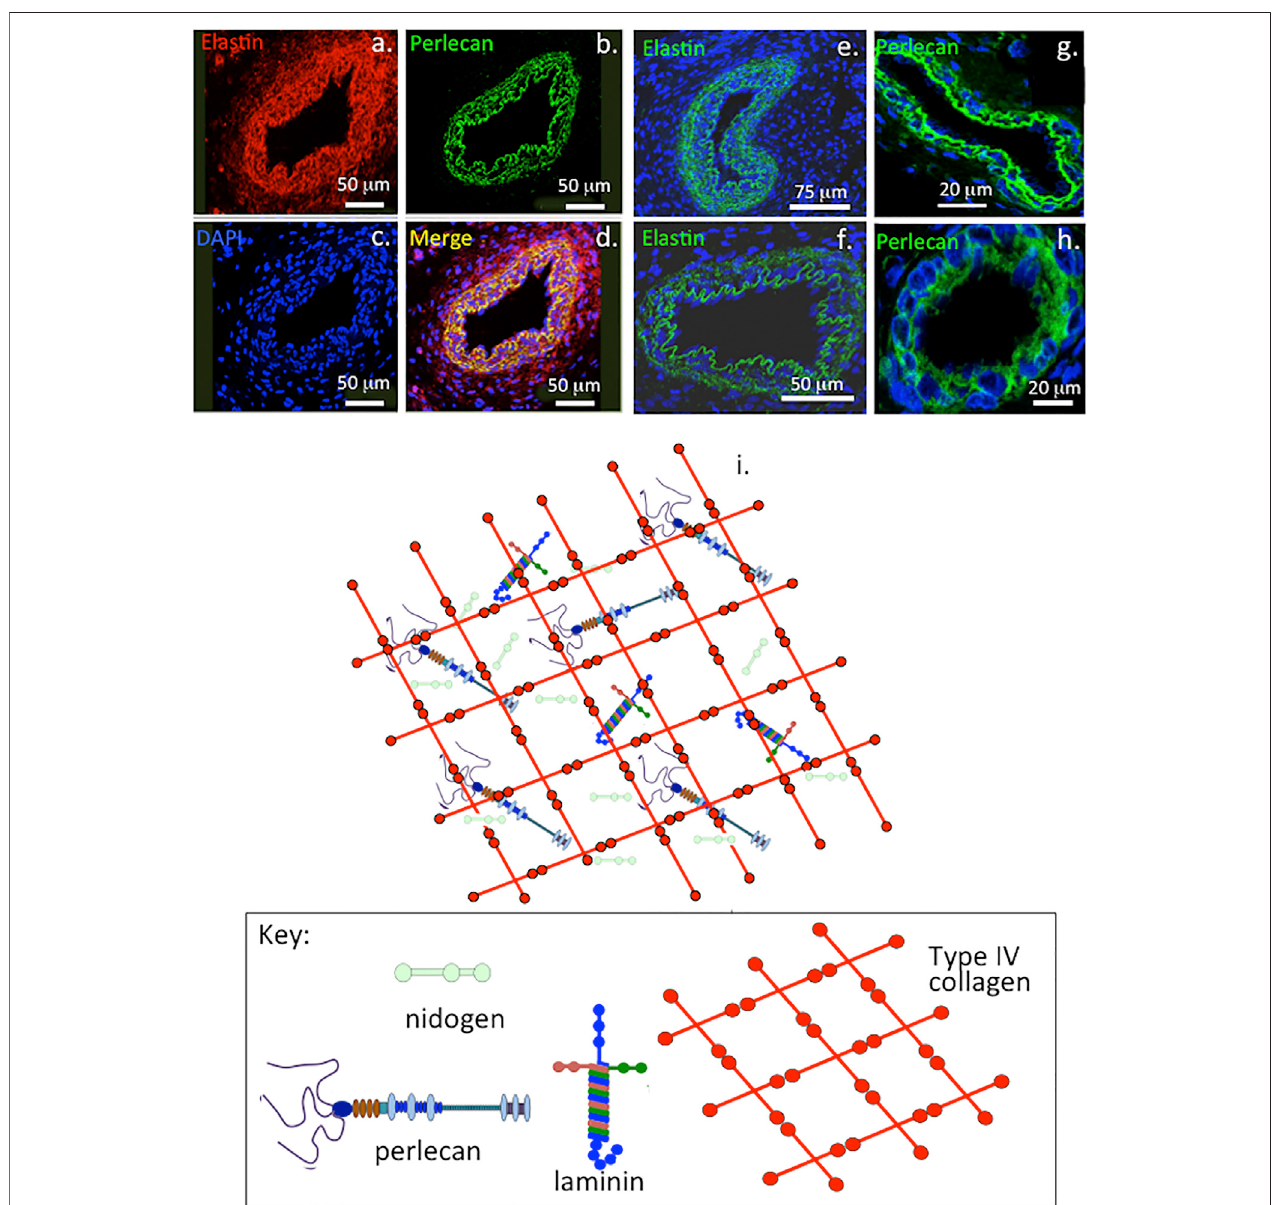
FIGURE 1 | Immuno fl uorescent colocalisation of perlecan and elastin in transverse sections of blood vessels (A – D) and immunolocalisation of elastin (E,F) and perlecan (G,H) in venules (E,G) and capillaries (F,H) . The underlying schematic depicts the major extracellular matrix components of basement membranes highlighting perlecan ’ s interactive role in maintaining integrity of this structure (I) . (A – H) reproduced from (Hayes et al., 2011a) with permission.